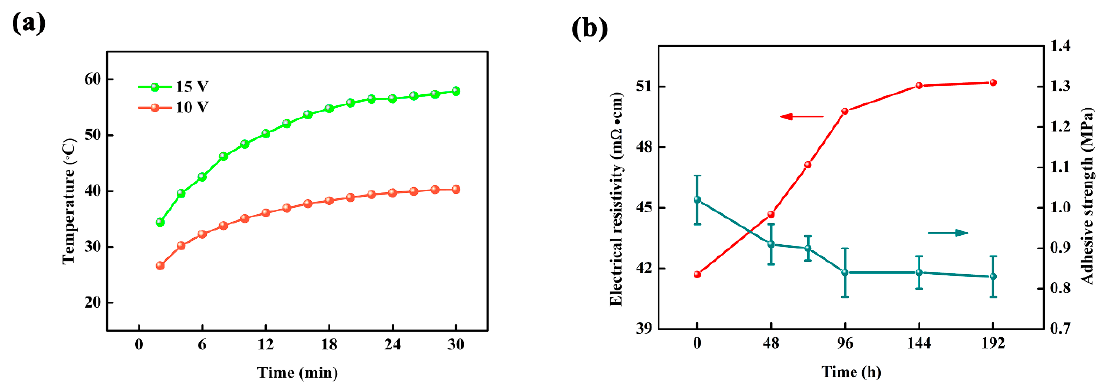
Figure 5. ( a ) The effect of applied voltage on the surface temperature of the laminated ceramics with carbon-based suspension thickness of 1.0 mm; ( b ) adhesive strength and electrical resistivity of the carbon-based layer with suspension thickness of 1.0 mm after aging at 100 °C up to 192